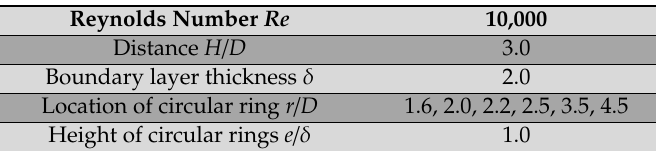
Table 4. Experimental conditions for locations of circular